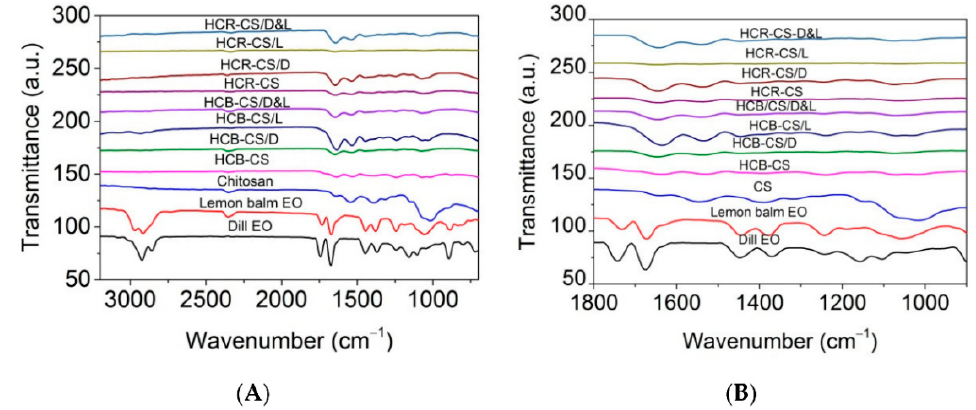
Figure 13. Comparative FTIR data of various samples between 4000 and 700 cm − 1 ( A ); zoomed in range of 1800 and 900 cm − 1 ( B ). Abbreviations and represented names in the figure as follows: dill EO (AGEO), lemon balm EO (MOEO), HCB-CS (mixture of collagen hydrolysates of bovine source (HCB), and chitosan (CS)), HCB-CS/D (mixture of collagen hydrolysates of bovine source (HCB) and chitosan (CS) along with the AGEO), HCB-CS/L (mixture of collagen hydrolysates of bovine source (HCB) and chitosan (CS) along with the MOEO), HCB-CS/D&L (mixture of collagen hydrolysates of bovine source (HCB) and chitosan (CS) along with the AGEO and MOEO), HCR-CS, HCR-CS/D, HCR-CS/L, HCR-CS/D&L. Reproduced from Rapa et al. [ 116 ] under a Creative Common CC BY license.